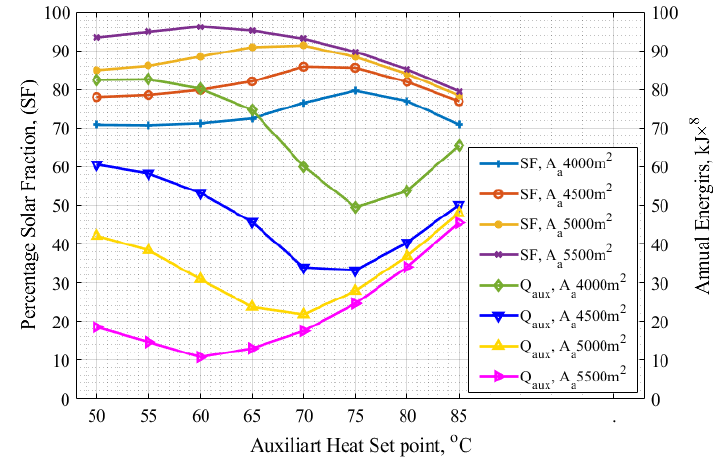
Figure 13. The solar fraction and annual auxiliary energy need vs. the auxiliary heat setpoint temperature for different solar field sizes and a storage volume of 350 m 2 .